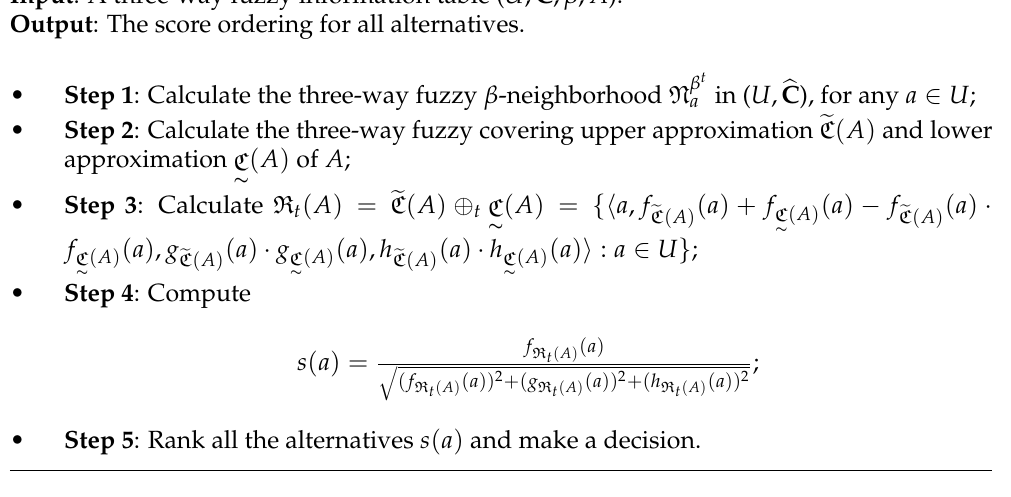
Algorithm 1 The MCDM algorithm under the three-way fuzzy covering rough set